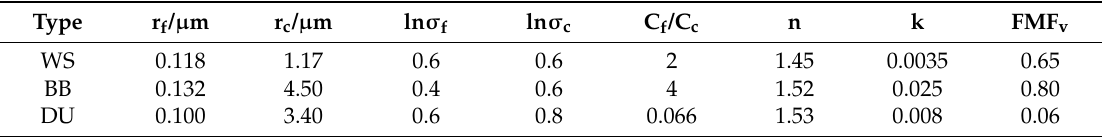
Table 1. The parameters of the water-soluble (WS), biomass burning (BB), and dust (DU) models in the fine mode fraction (FMF) calculation.